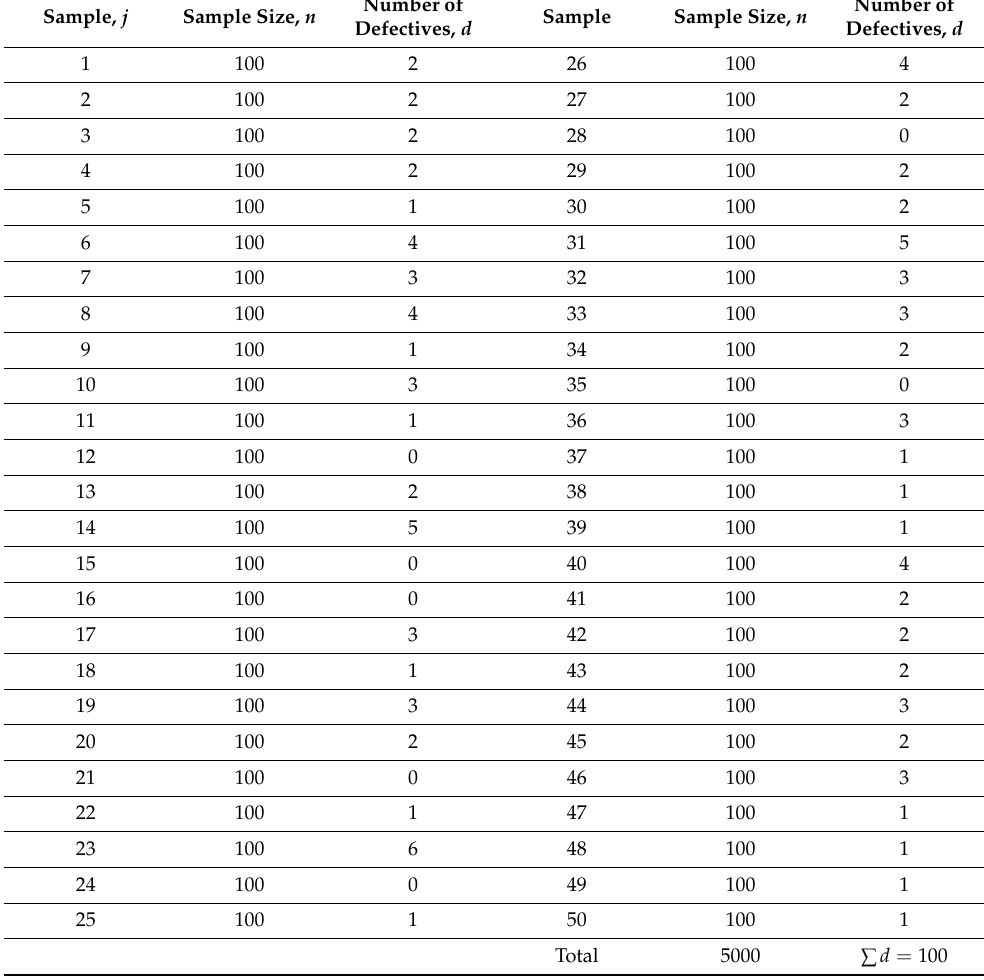
Table 7. Data related to the process of producing ballpoint pen cartridges. Source Oakland [39].